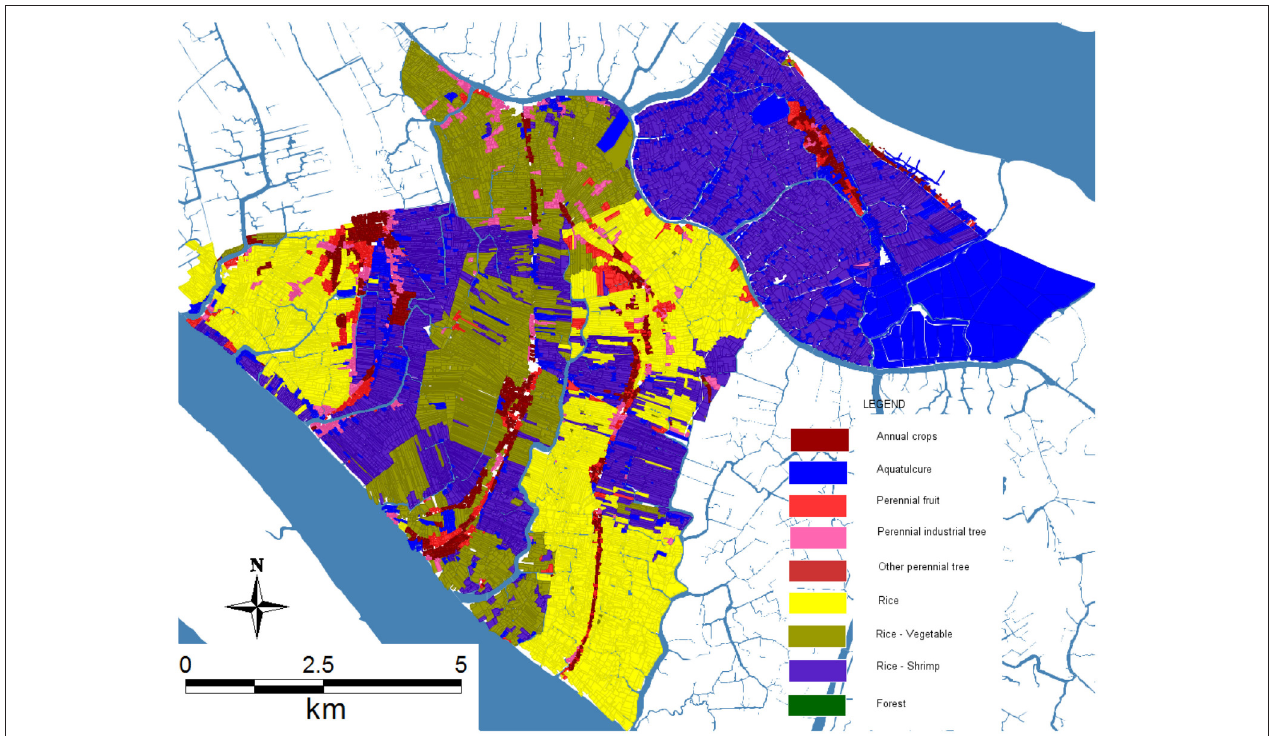
FIGURE 8 | Land-use map of five villages (An Thanh, Binh Thanh, An Thuan, An Quy, An Nhon, An Dien) of Thanh Phu district in 2005.